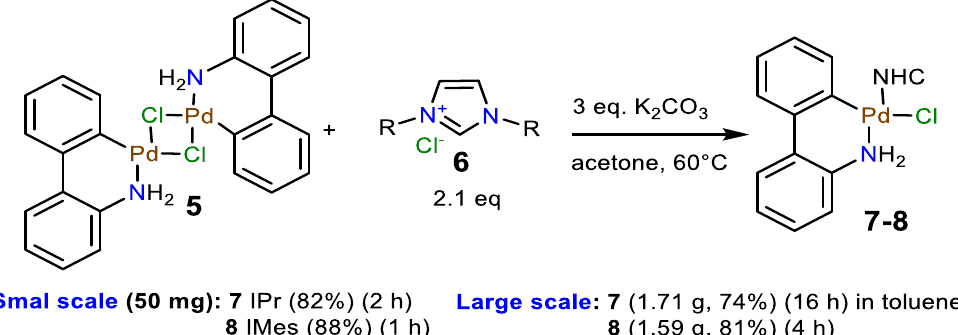
Figure 3. Scheme of the synthesis of palladacycle [Pd(NHC)(NH 2 )(CC)Cl] complexes.